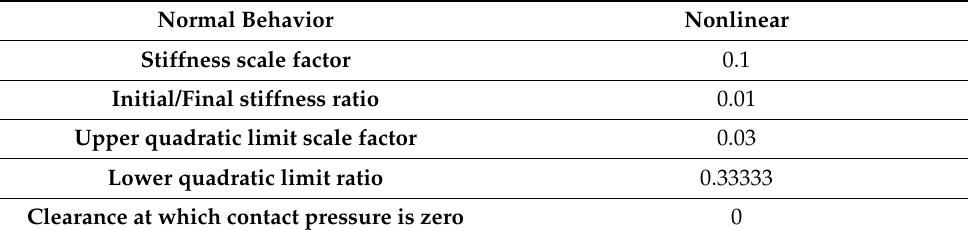
Table 3. Contact stiffness parameters.